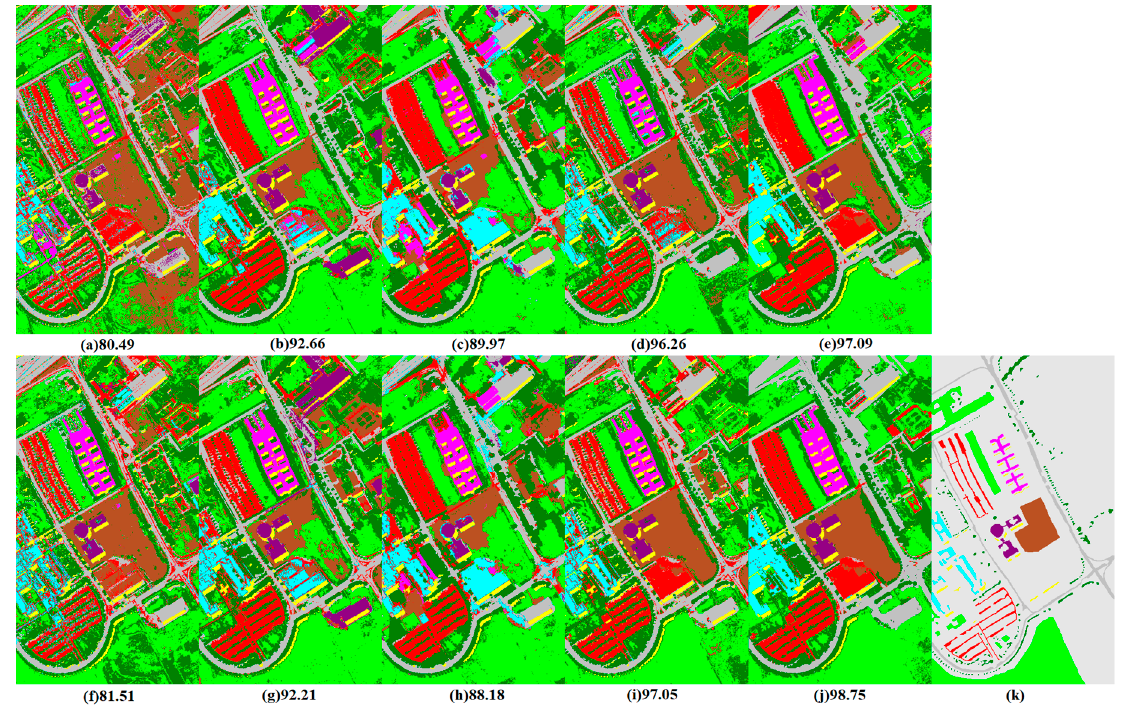
Figure 6. Classification maps with OA values ( a – j ) corresponding to Table 1 and ground truth map, ( k ) for comparison with Pavia University test data.